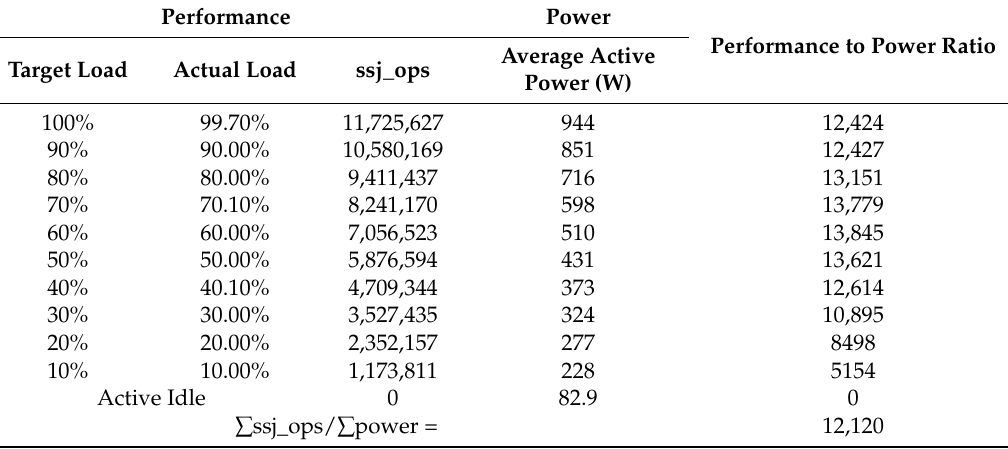
Table 1. Sample result of SPECpower_ssj2008.